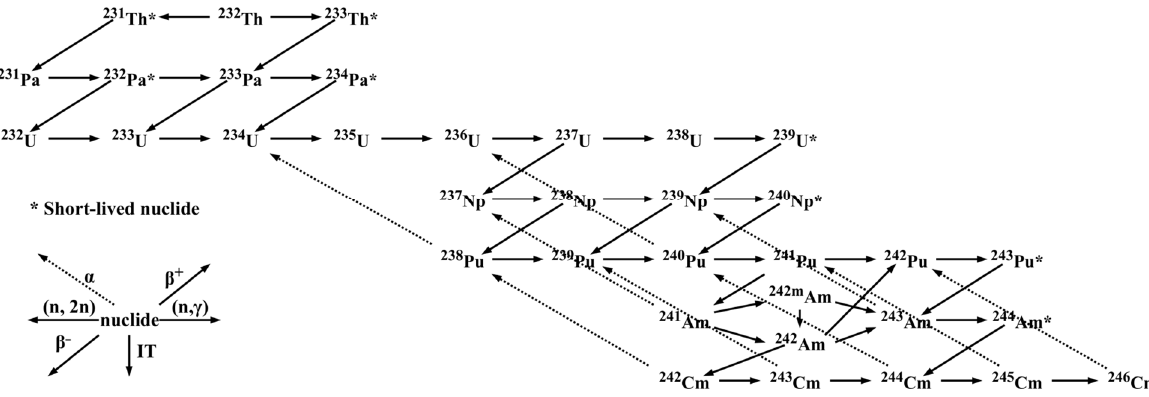
Figure 11. Simplified reaction chains of the main actinides [26].